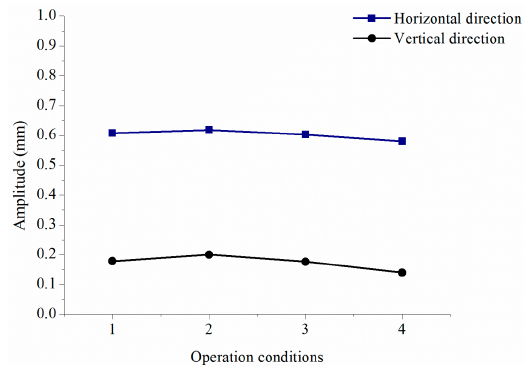
Figure 24. Horizontal and vertical amplitudes of four settlement conditions.